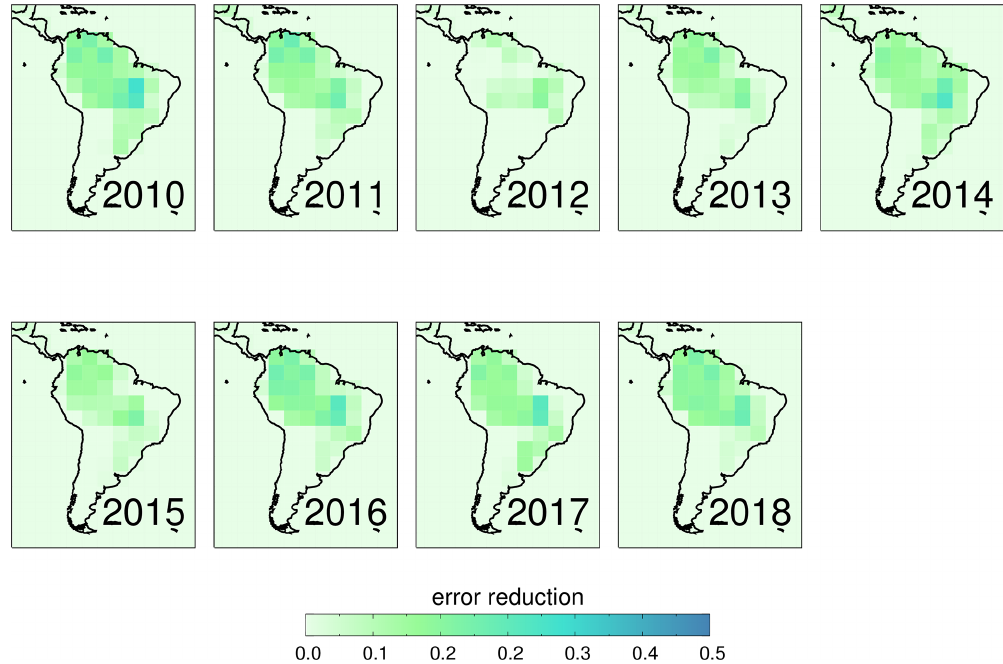
Figure A4. Mean annual South American posterior error reduction after assimilation of GOSAT XCH 4 and surface flask observations. Error reduction is defined as 1.-( σ _a/ σ _b), where σ _a is the derived standard deviation of the a posteriori grid cell flux uncertainty and σ b is the allocated a priori standard deviation of the grid cell flux